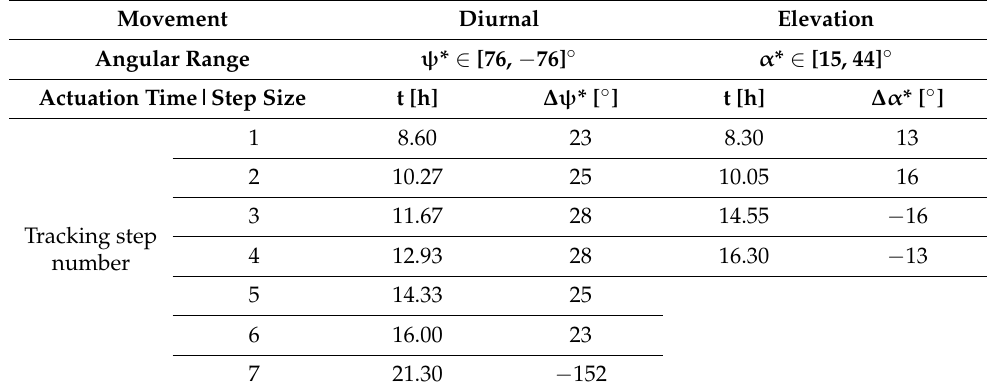
Table 4. Tracking program “3”/“11”.